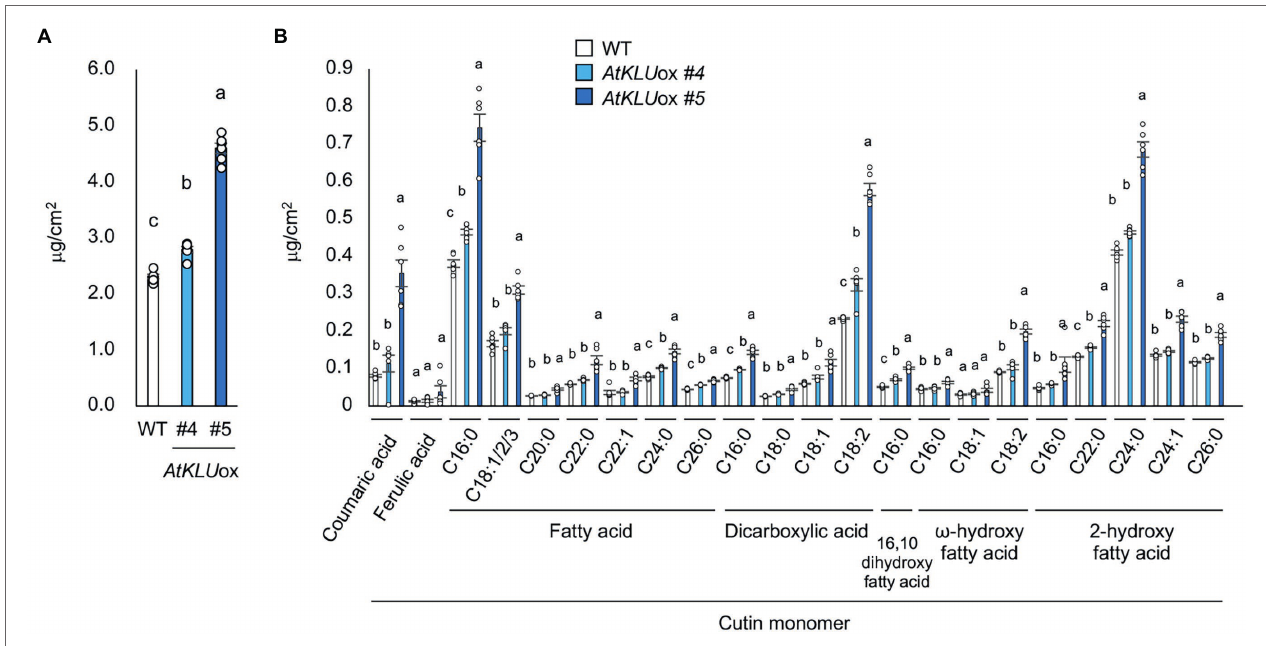
FIGURE 6 | Cutin monomer content and composition of 4-week-old WT and AtKLU ox seedlings. (A) Total cutin monomer content of WT and AtKLU ox plants. (B) Identified cutin monomers (coumaric acid, ferulic acid, fatty acids, dicarboxylic acids, 16, 10 dihydroxy fatty acid, ω -hydroxy fatty acids, and 2-hydroxy fatty acids) in WT and AtKLU ox plants. The C16 ~ 26 labels on the x axis indicate chain length. Data represent means ± SE, n = 6. Within each compound type and chain length, values marked with the same letter are not significantly different based on one-way ANOVA and Tukey’s test, P <